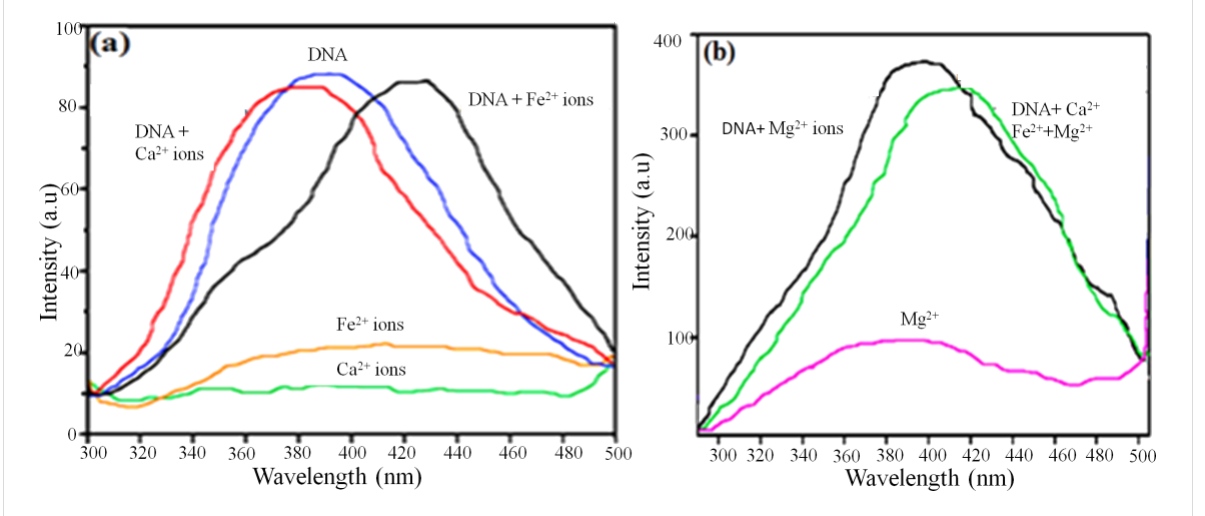
Figure 9: Change in fluorescence intensity for a sample with (a) Fe 2+ and Ca 2+ ions and (b) Mg 2+ ions, with and without DNA binding.